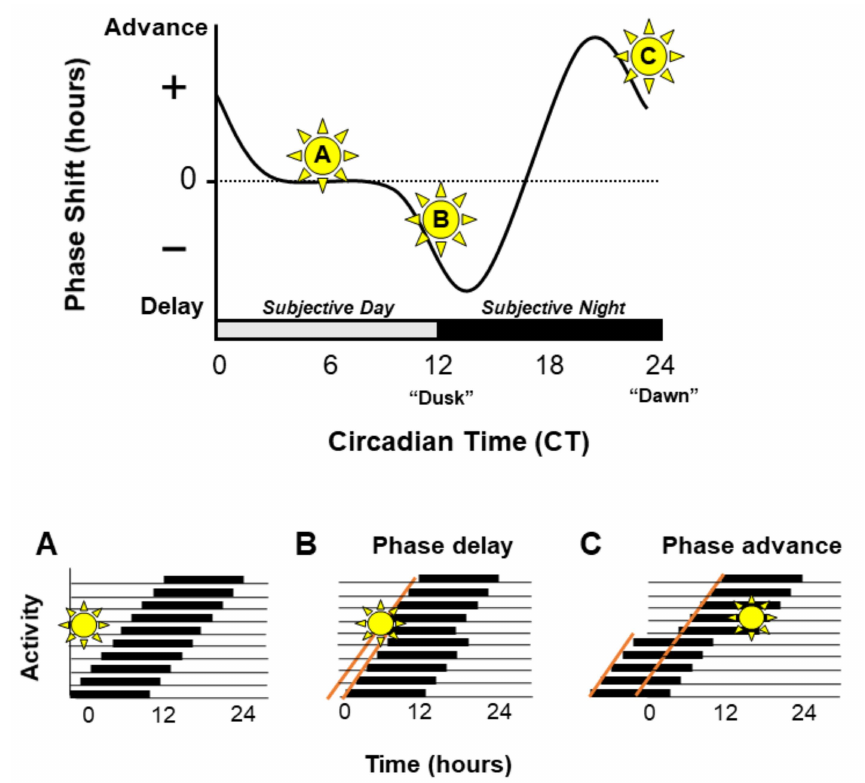
Figure 2. The phase response curve. The phase response curve demonstrates the effect of light exposure at different times of the circadian cycle on the phase of the circadian clock. Light delivered during the subjective day, the ‘dead-zone’ will have no effect on the phase of the clock ( A ). Light exposure during the early subjective night will lead to delays in the phase of the clock ( B ). Whereas light exposure at the end of the subjective night will lead to phase advances ( C ). This is demonstrated by representative actograms showing free running rest/activity rhythms (panels A – C ); black bars represent periods of activity and black lines indicate